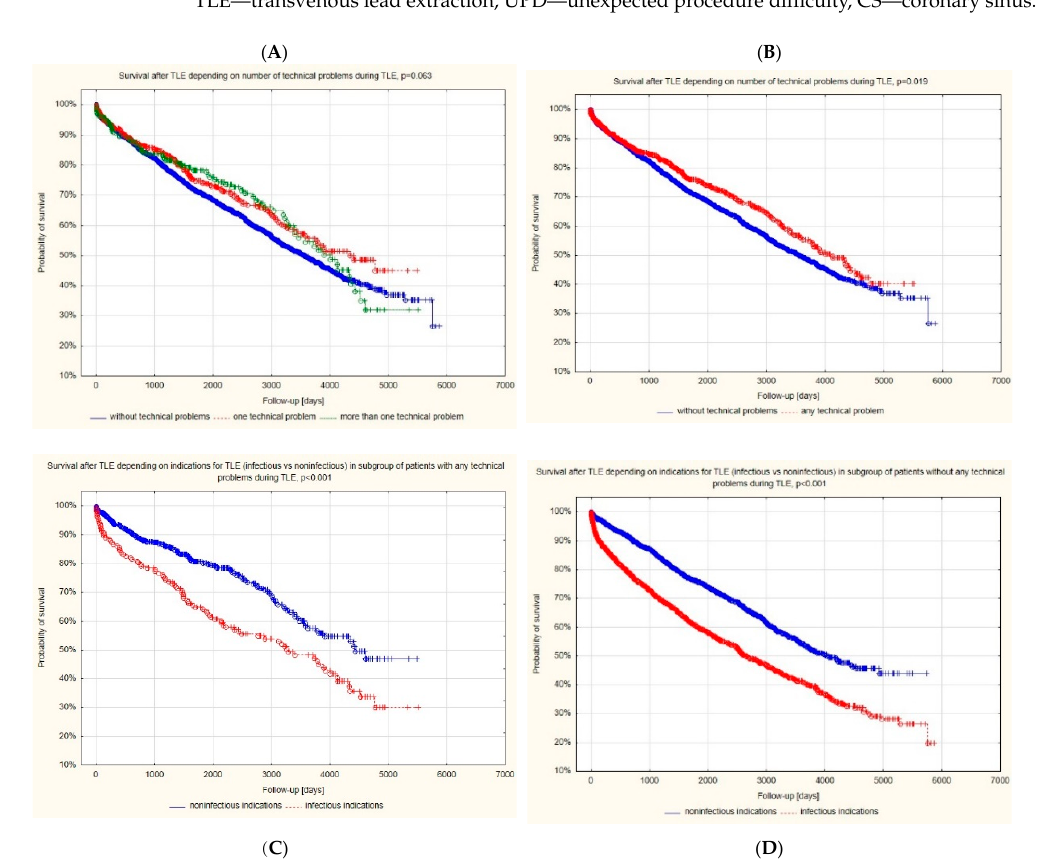
Figure 3. ( A–D ) Prognostic impact of UPDs during lead extraction on survival after TLE. Results Recapitulation Blockage in the lead implant vein/subclavian region is caused by too parasternal a puncture of the subclavian vein or occlusion of the vein with dense scar tissue (Figure 4). This problem was present in 297 patients (7.98%). It was not associated with patient- related risk factors, only slightly associated with the number of leads and the presence of abandoned leads, but it was strongly related to implant duration. In our estimation, this is a UPD caused by a previous operator. Its presence prolonged lead extraction and forced the extractor to use second-line tools i.e., metal sheaths or mechanical rotational threaded sheaths when a standard stepwise and cross-over strategy was utilised. Furthermore, it was weakly related to major complications (MC), lower rates of radiographic success (non-removable lead fragments), and therefore lower rates of procedural success, but not to long-term mortality.